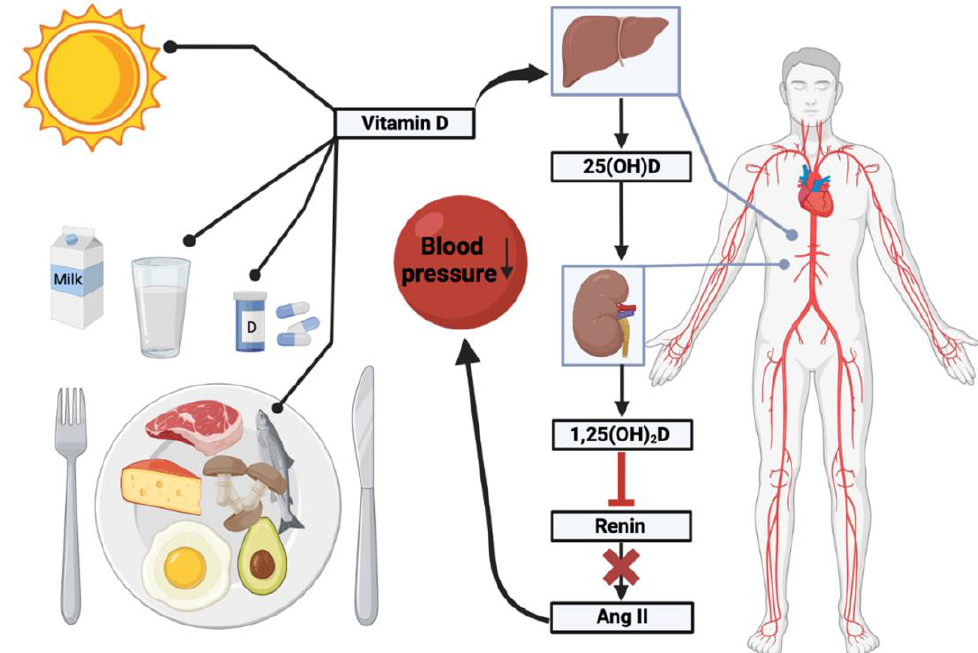
Figure 1. Illustrated abstract of Vitamin D and its role in hypertension. This figure was made using Biorender.com, agreement number MD24V0MZH0.